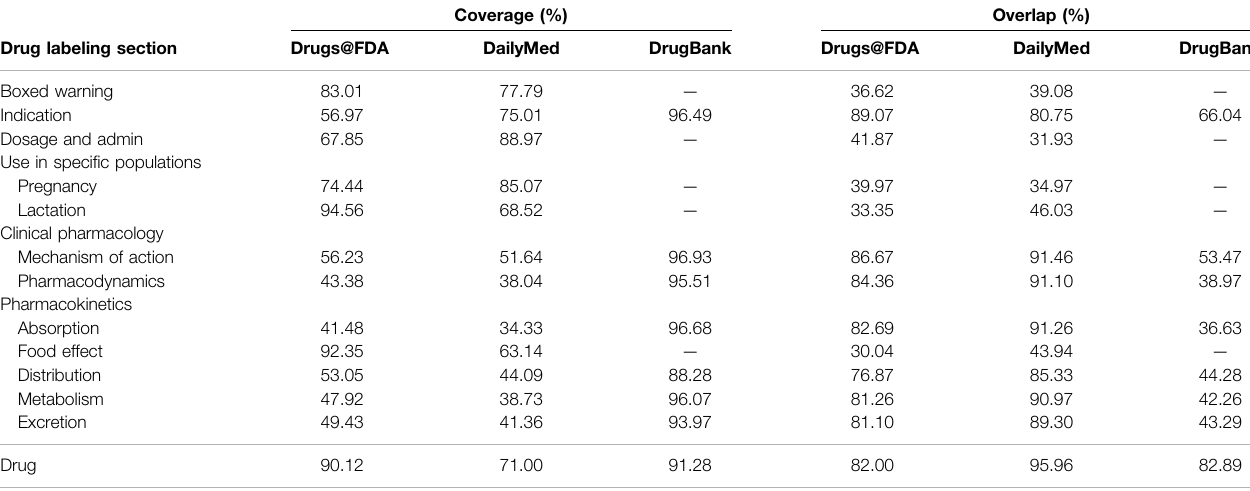
TABLE 4 | Comparison of Source Coverage and Overlap of Unique Drug and Drug Labeling Sections.